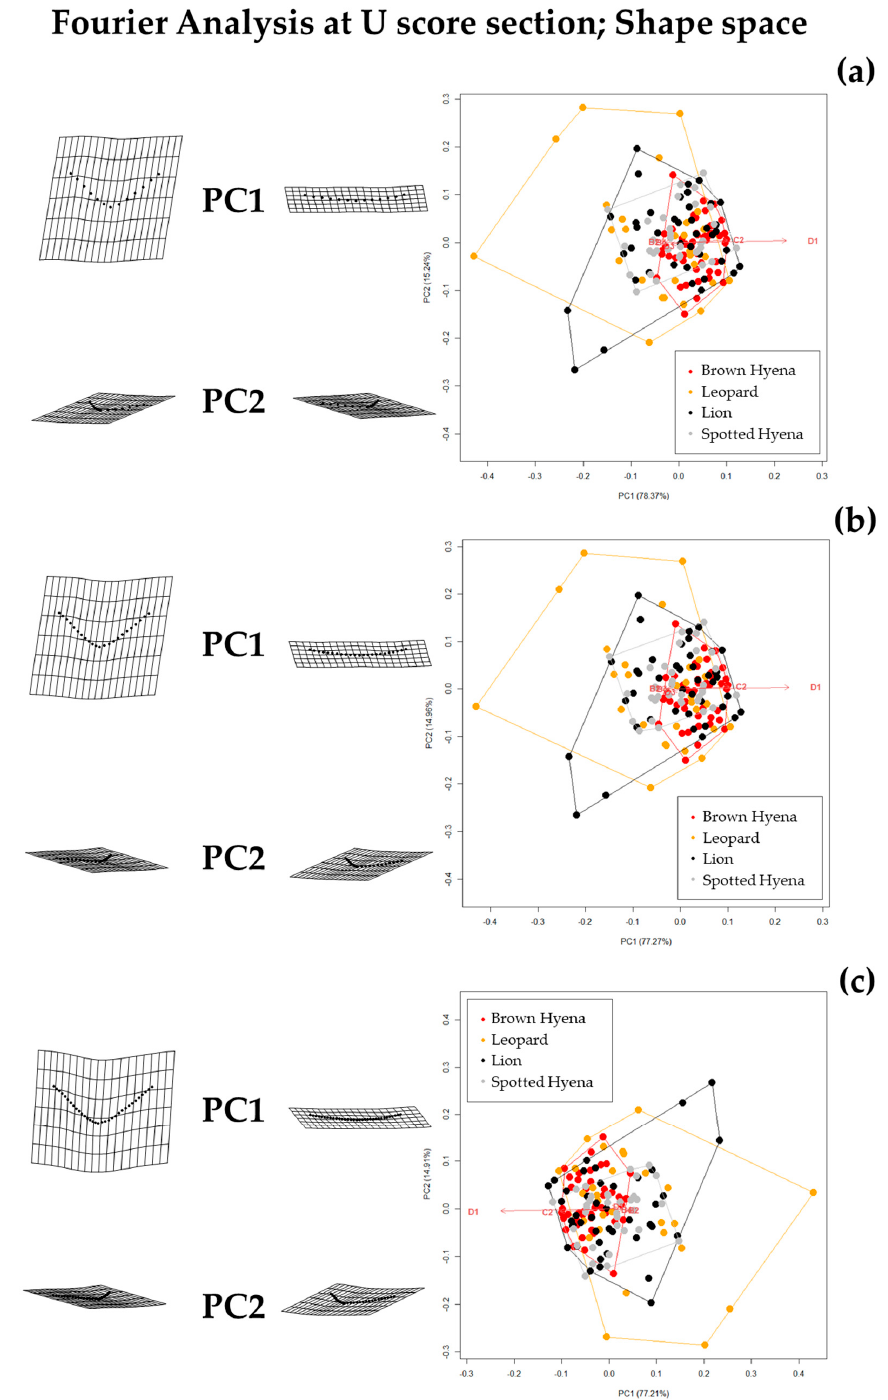
Figure 7. Shape PCA plots on Elliptic Fourier Analysis on the 2-curves semilandmark models at the most conspicuous U score section, using ( a ) 13 points; ( b ) 23 points; and ( c ) 33 points. Extreme changes in shape along PC1 and PC2 are illustrated with the aid of transformation grids. Optimal harmonics for each model are ( a ) 4; ( b ) 6; and ( c ) 6.